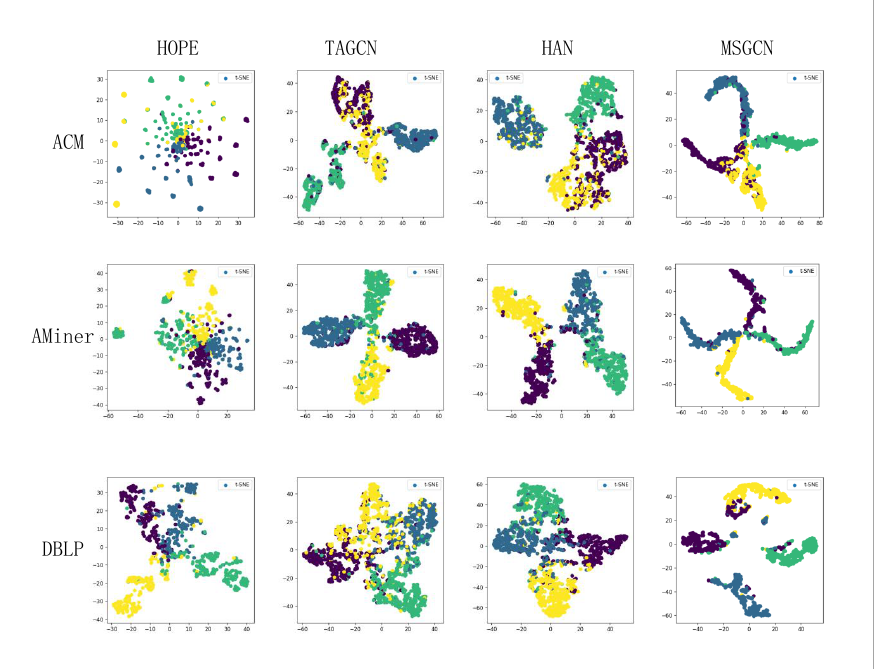
Figure 4. The visualization results of the models. Models include HOPE, TAGCN, HAN, and MSGCN. We conduct experiment on node classification task on three dataset. The visualization results demonstrate the superiority of our model.